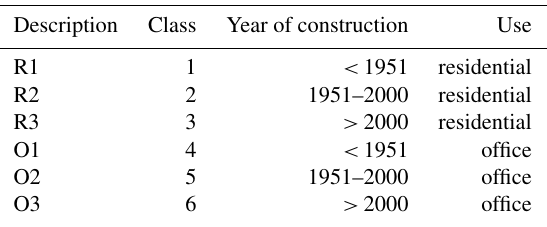
Table A2. Building classification parameters according to building_type based on building age and